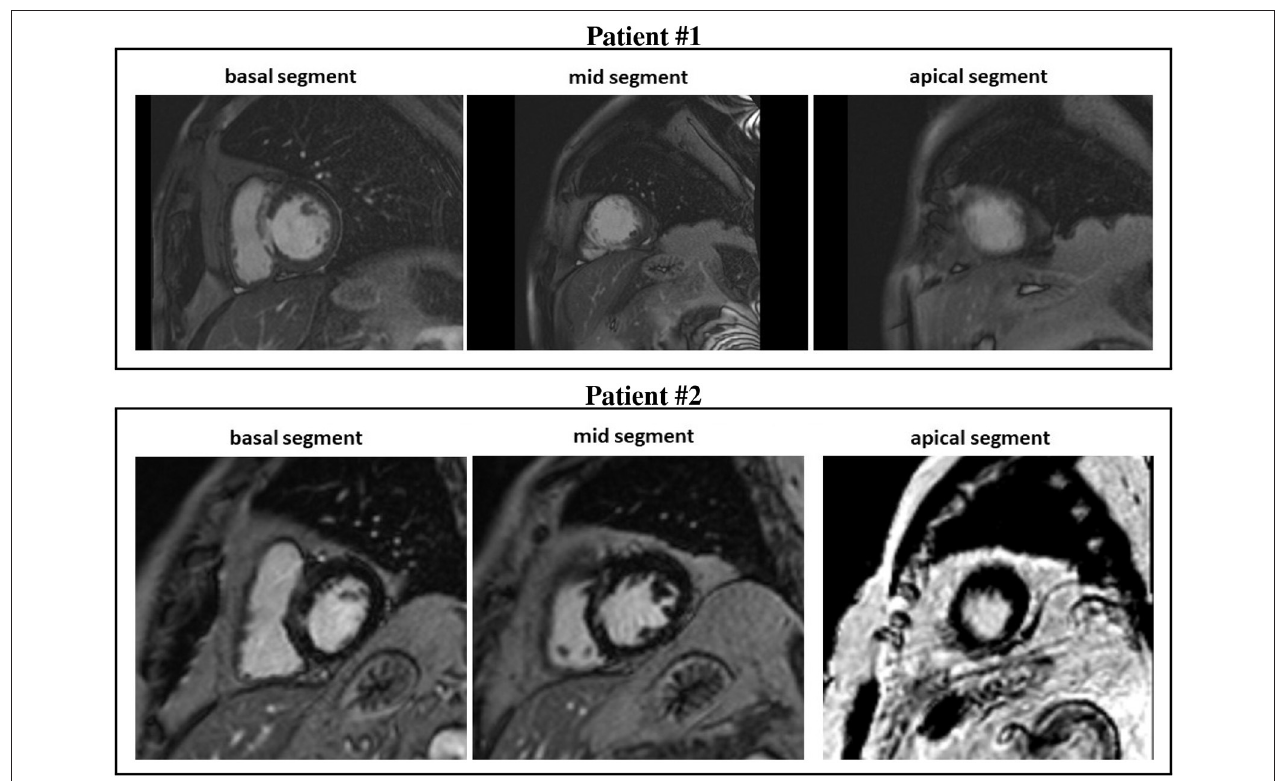
FIGURE 1 | Cardiovascular magnetic resonance (CMR) short-axis slices of the basal, mid, and apical segment of patients #1 and